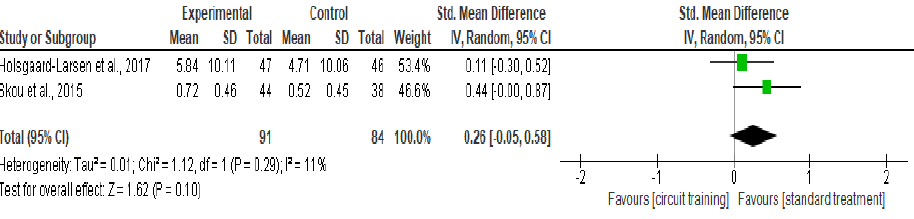
Figure 9. Forest plot analysis of the effect of CT on knee symptom [41,43].